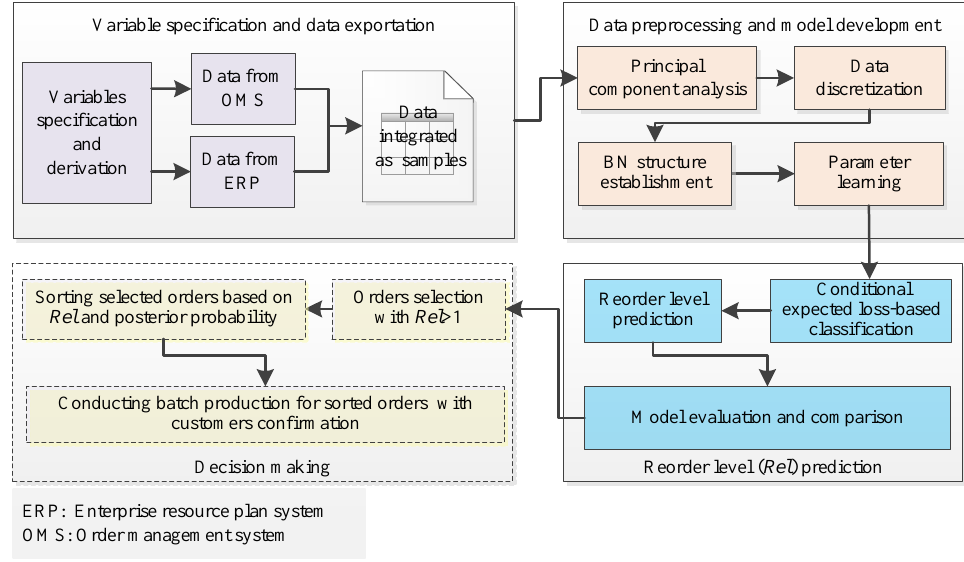
Figure 1. The framework of the reorder level prediction for batch production.